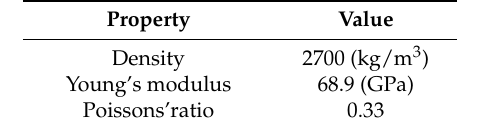
Table 1. Properties of the 6061-T6 aluminum plate.